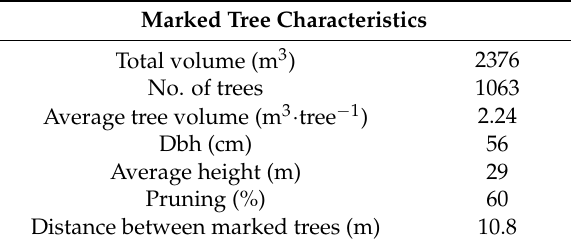
Table 1. Characteristics of marked